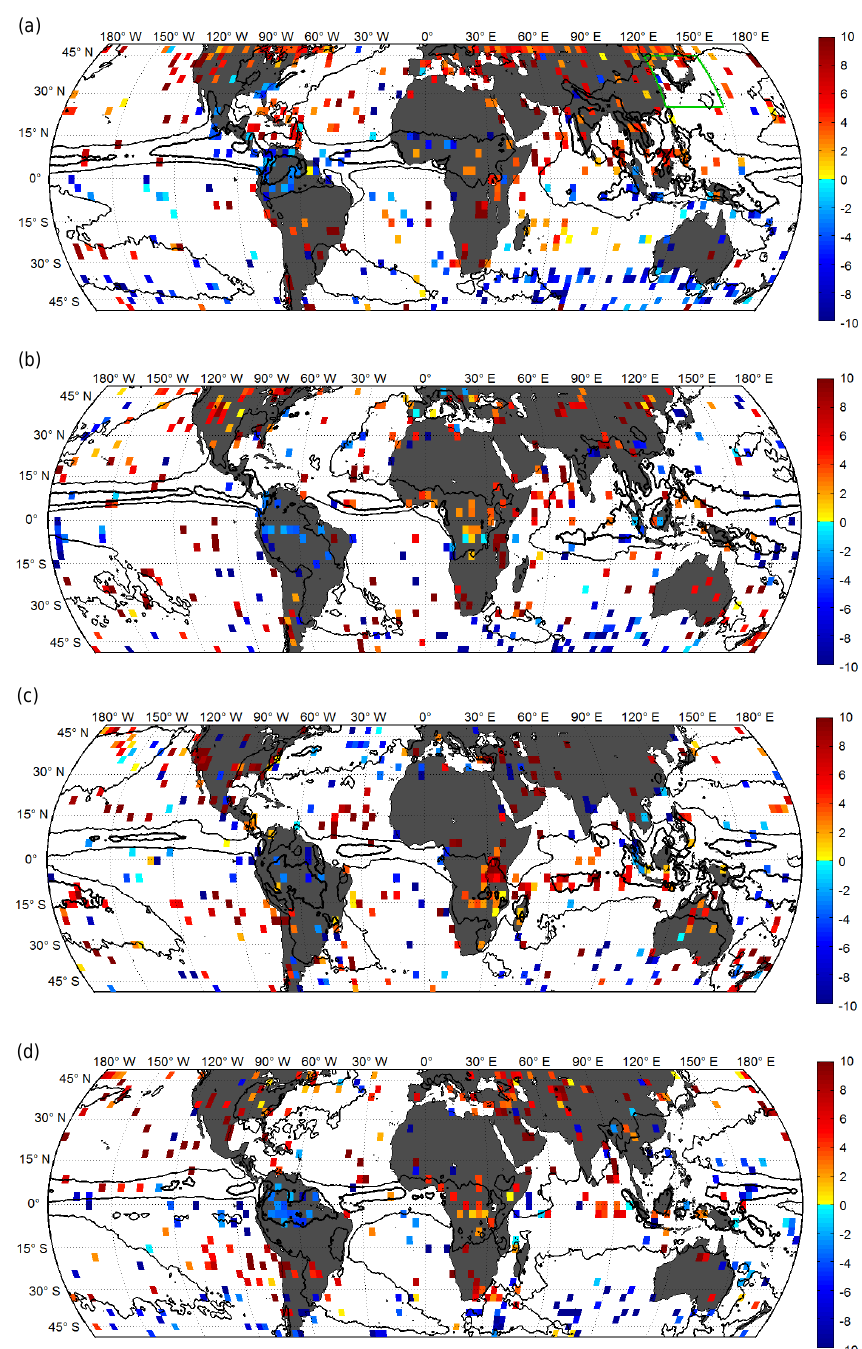
Figure 11. Mean difference in UTH (in %RH) between cases when AOD is higher and cases when AOD is lower than each grid box median for four seasons in 2007–2013: (a) June, July and August, (b) September, October and November, (c) December, January and February, (d) March, April and May. Precipitation binning and cirrus correction were applied to the data and only grid cells with precipitation more than 1mmday − 1 were used. The data are averaged over 3 ◦ × 3 ◦ grid and only grid cells with statistically significant differences ( t test with the 10% significance level) are shown. Black contours represent mean daily precipitation of 3, 9 and 30mm. The study region east of China is marked with a green box in (a) . Wet scavenging is likely to decrease (cid:49) UTH leading to a smaller statistical